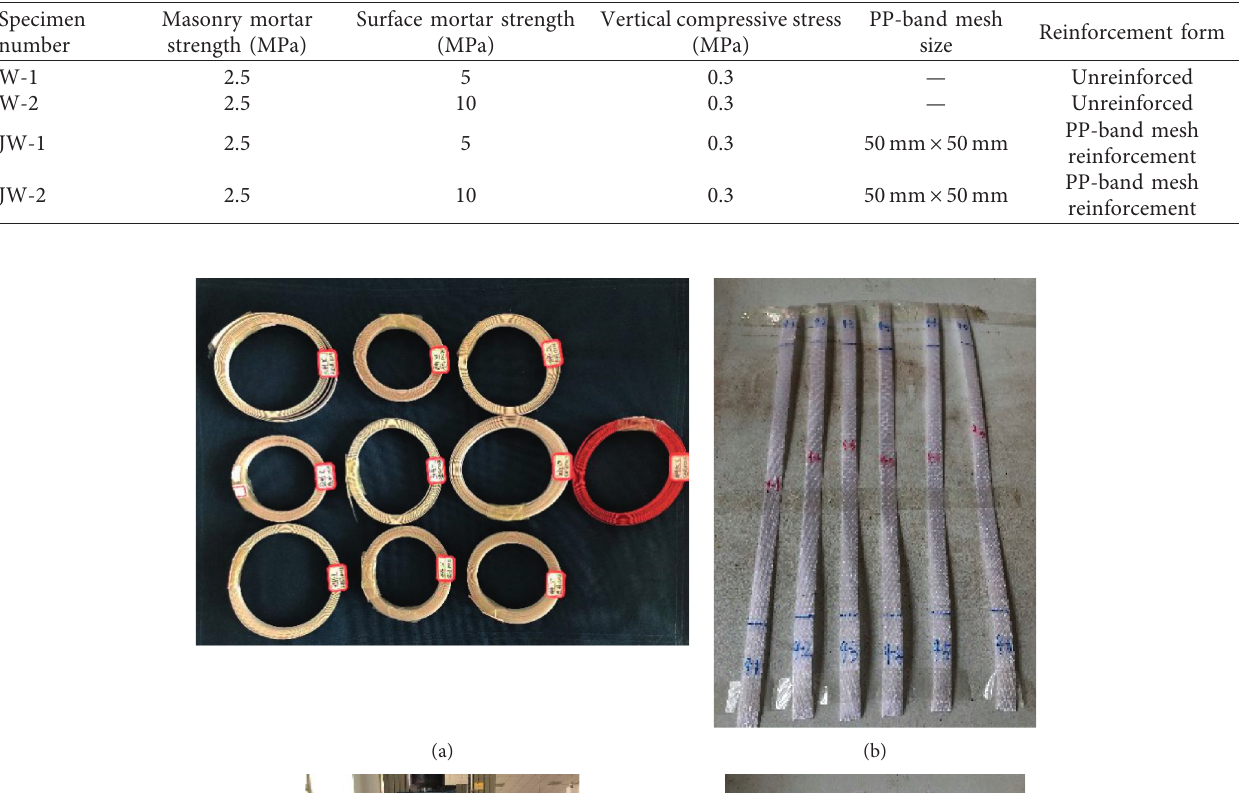
Table 1: The reinforced condition of each specimen.